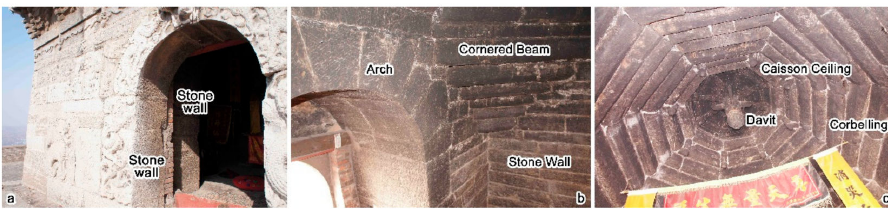
Figure 3. Detail of the structure of the Limestone Hall ( a ) the arch in the south of Limestone hall, ( b ) interior wall and inclined beam of Limestone hall, and ( c ) the octagonal dome in the interior of the Limestone Hall.